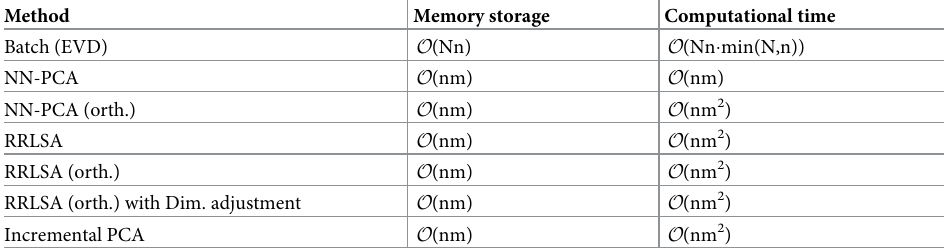
Table 7. Comparison of algorithmic complexity regarding computation time and memory consumption for each data point presentation.